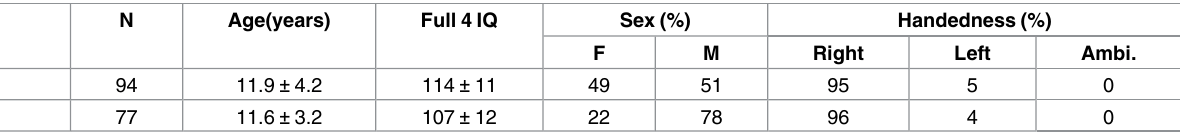
Table 2. Details of Holdout Datasetparticipants, ADHD-200.